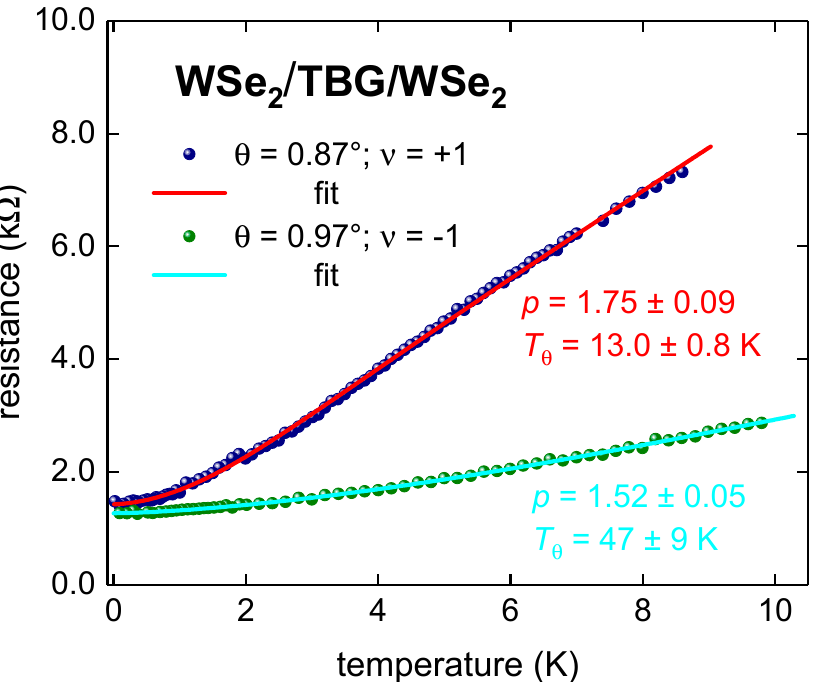
Figure 4. R ( T ) fits to Equation (7) for WSe 2 /TBG/WSe 2 (raw data reported by Arora et al. [11]) for θ = 0.87° and θ = 0.97°. 95% confidence bands are shown. Goodness of fit is better than R = 0.998.